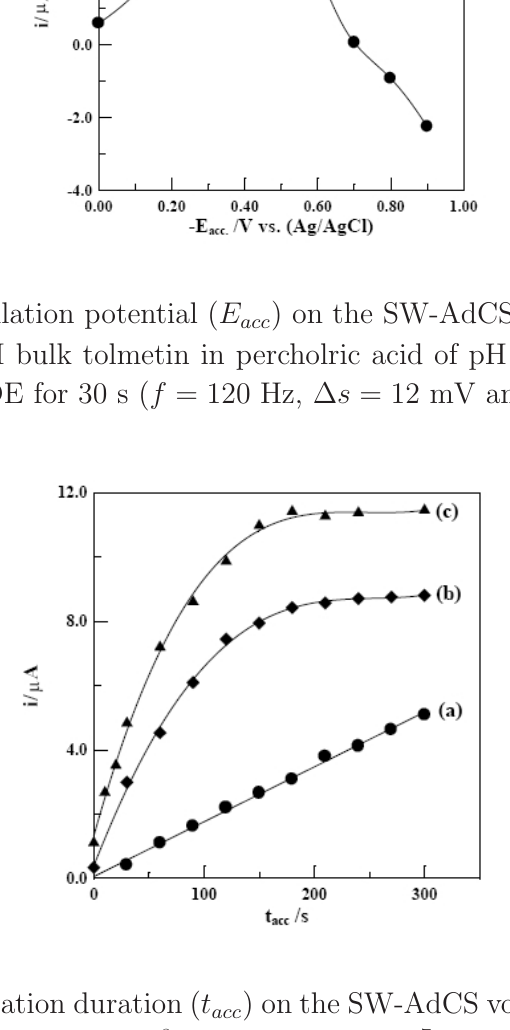
Fig. 5 Effect of accumulation duration ( t acc ) on the SW-AdCS voltammetric peak current ( i p ) for; (a) 1 × 10 − 8 M, (b) 5 × 10 − 8 M and (c) 1 × 10 − 7 M bulk tolmetin in percholric acid of pH 2 ( E acc = − 0 . 4 V f = 120 Hz, Δ s = 12 mV and E sw = 50